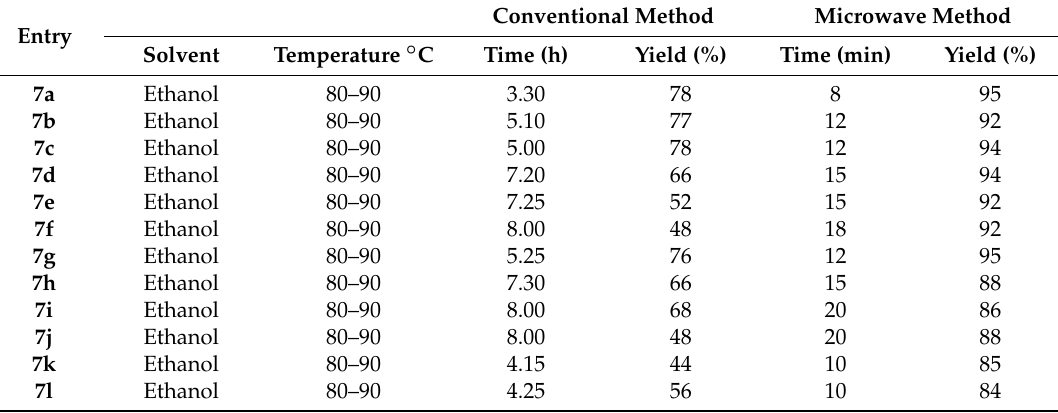
Table 1. Details of synthesis of N -((5-(Substituted methylene amino)-1,3,4-thiadiazol-2-yl)methyl) benzamide derivatives 7 ( a – l ) using conventional method and microwave method.